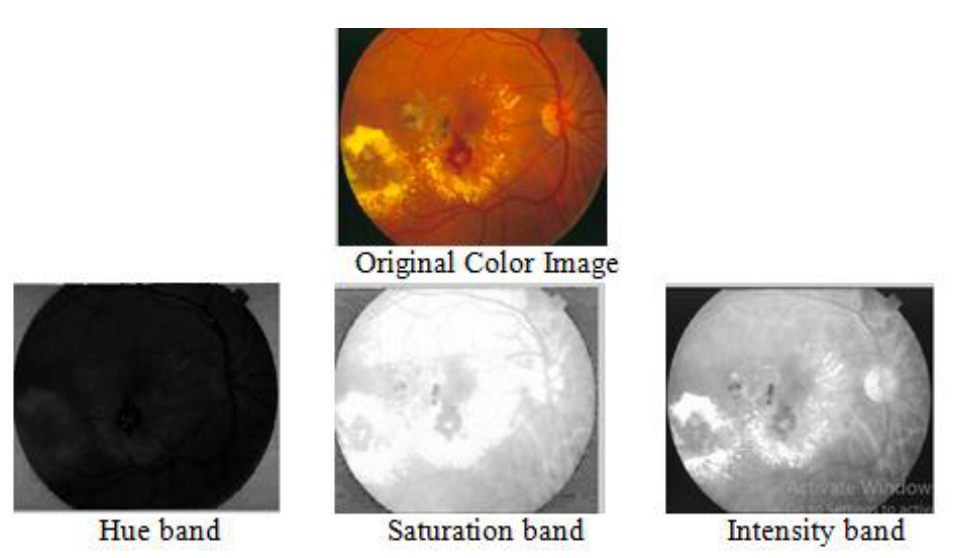
Fig.4: The color spaces convert process from RGB to